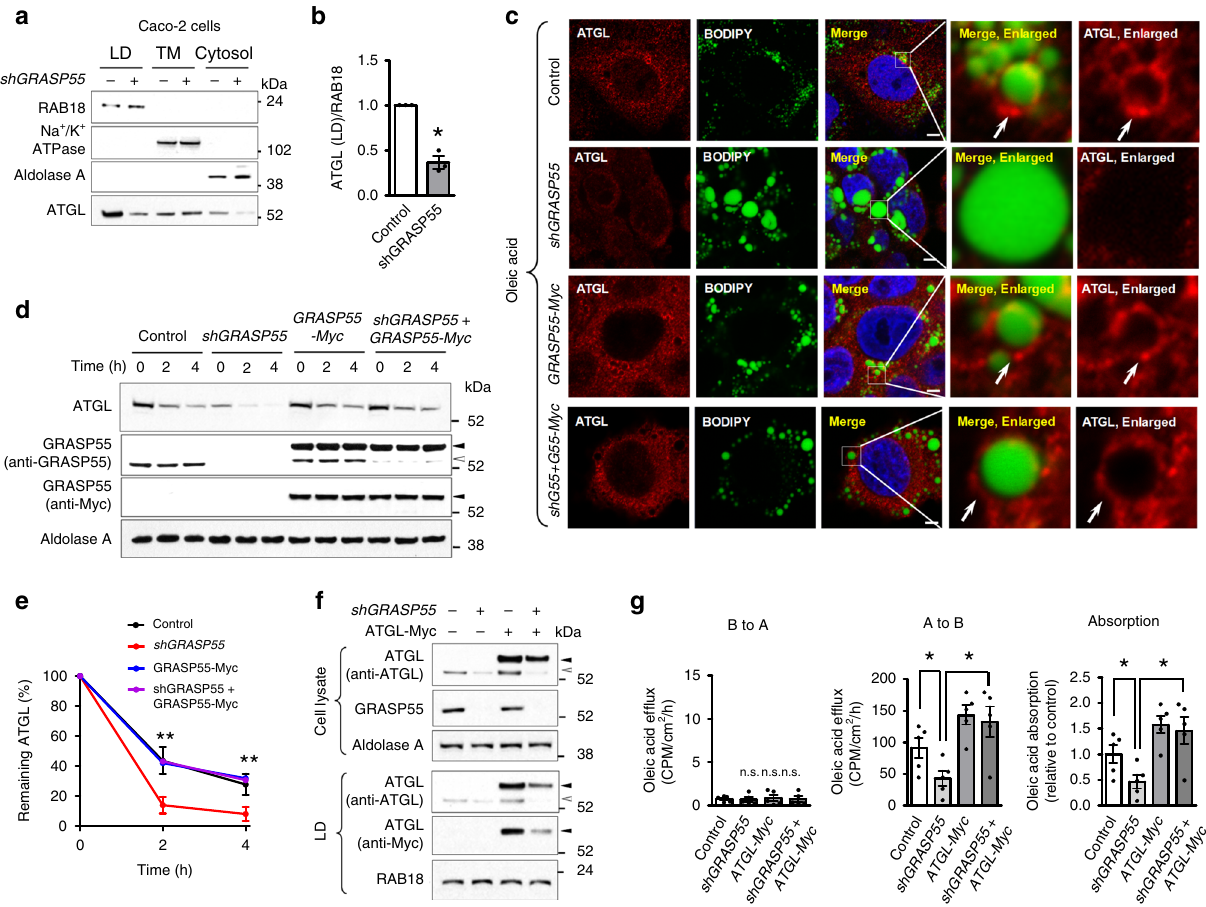
Fig. 6 GRASP55 depletion reduces LD targeting of ATGL and transepithelial lipid absorption in Caco-2 cells. a , b Measurements of ATGL in the lipid droplet (LD) fraction of Caco-2 cells after treatment with 400 μ M oleic acid for 16 h. Representative immunoblots are shown in ( a ) and a summary of multiple experiments is shown in ( b , n = 3). c Presence of ATGL on the LD surface was examined by co-staining with anti-ATGL antibodies and BODIPY 493/503 (an LD marker) in Caco-2 cells, in which endogenous GRASP55 was depleted ( shGRASP55, shG55 ) and/or exogenously supplemented ( GRASP55- Myc, G55-Myc ). Cells were treated with 400 μ M oleic acid for 4 h before immunostaining. Arrows indicate the location of ATGL, which is targeted to the peripheral regions of LDs. Four independent experiments showed similar results. d , e ATGL protein stability was examined in Caco-2 cells, in which GRASP55 was depleted ( shGRASP55 , open arrowhead) and/or exogenously supplemented ( GRASP55-Myc , fi lled arrowhead). Cytosolic proteins were collected 0, 2, and 4 h after treatment with cycloheximide (0.1 mg ml − 1 ), an inhibitor of protein biosynthesis. Aldolase A was used as a cytosolic protein loading control. Representative immunoblot is shown in ( d ), and the results of multiple experiments are summarized in ( e , n = 3). f Immunoblot results of Caco-2 monolayers, in which GRASP55 was depleted ( shGRASP55 ) and exogenous ATGL ( ATGL-Myc ) was supplemented. Levels of endogenous ATGL (open arrowhead) and exogenous ATGL ( fi lled arrowhead) are shown. A high level of ATGL-Myc supplementation restored LD-associated ATGL levels in GRASP55-depleted cells, although the LD transport ef fi ciency was much lower (compare endogenous and exogenous ATGL levels in lanes 3 and 4). g Transepithelial lipid transport of Caco-2 monolayers were determined using 14 C-labeled oleic acid. The basolateral (B) to apical (A) transport of oleic acid (left, B to A) was much smaller than that of apical to basolateral transport (middle, A to B), and it was not affected by GRASP55 depletion or ATGL overexpression. Transepithelial lipid absorption was determined by subtracting values of (B to A) from those of (A to B) in each paired experiment (right, n = 4). ATGL overexpression rescued lipid absorption in GRASP55-de fi cient Caco-2 Cells. Unprocessed blots are presented in Supplementary Fig. 22. CPM, counts per min. TM, total membrane. Data are shown as mean ± SEM. Scale bars: 10 μ m. n.s.: not signi fi cant, * p < 0.05. P values were caluculated by paired ( b ), unpaired ( e ) two-tailed Student ’ s t tests or ANOVA followed by Tukey ’ s multiple comparison tests ( g ). Source data are provided as a Source Data fi